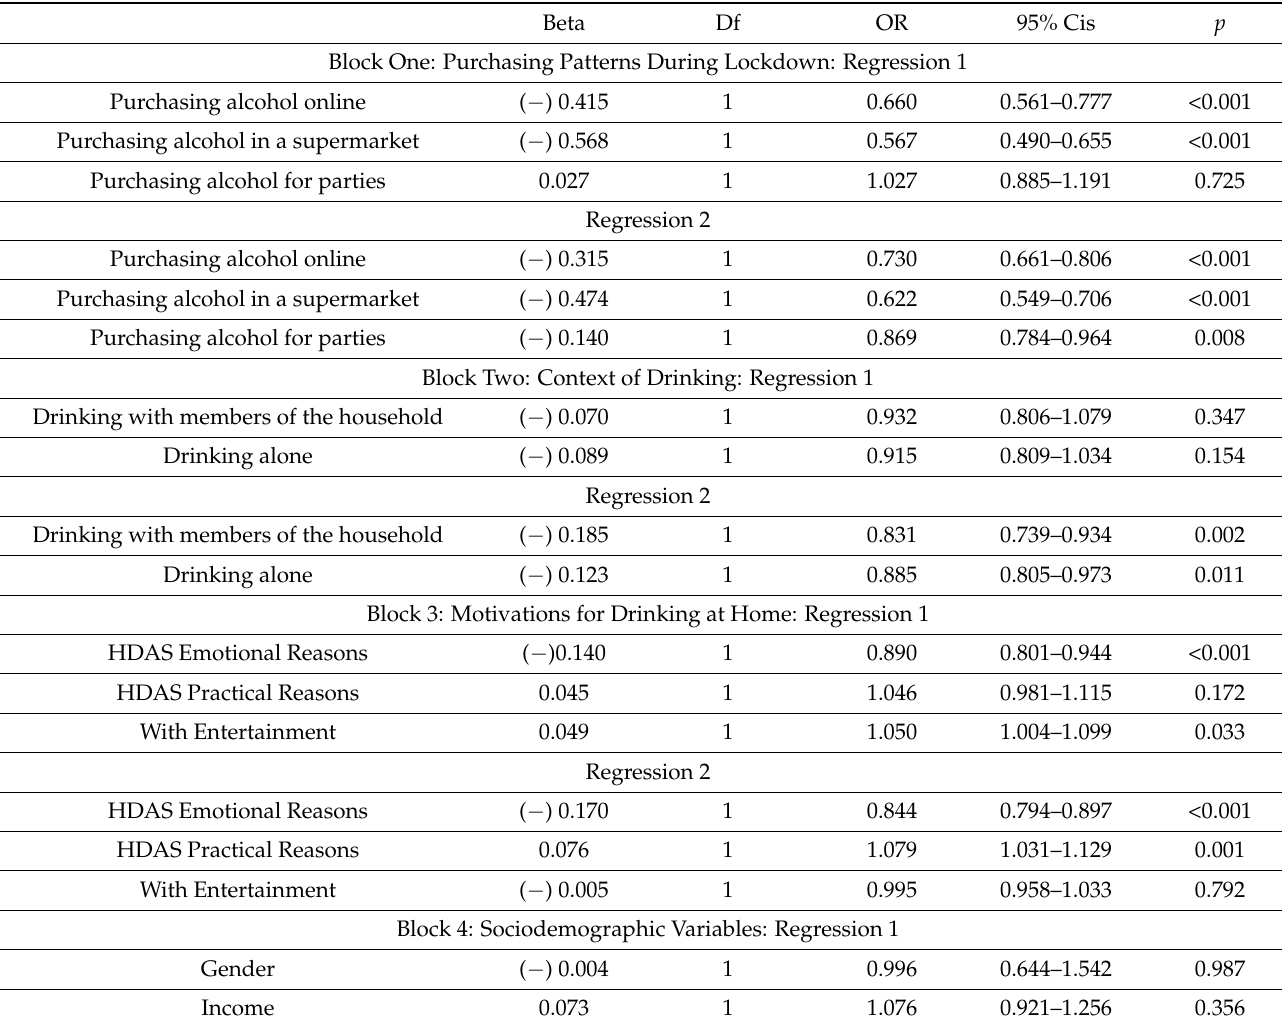
Table 4. Hierarchical regression for Regression 1 (AUDIT-C cut-off 5 for both genders) and Regression 2 (AUDIT-C scores of 7 for females and 8 for